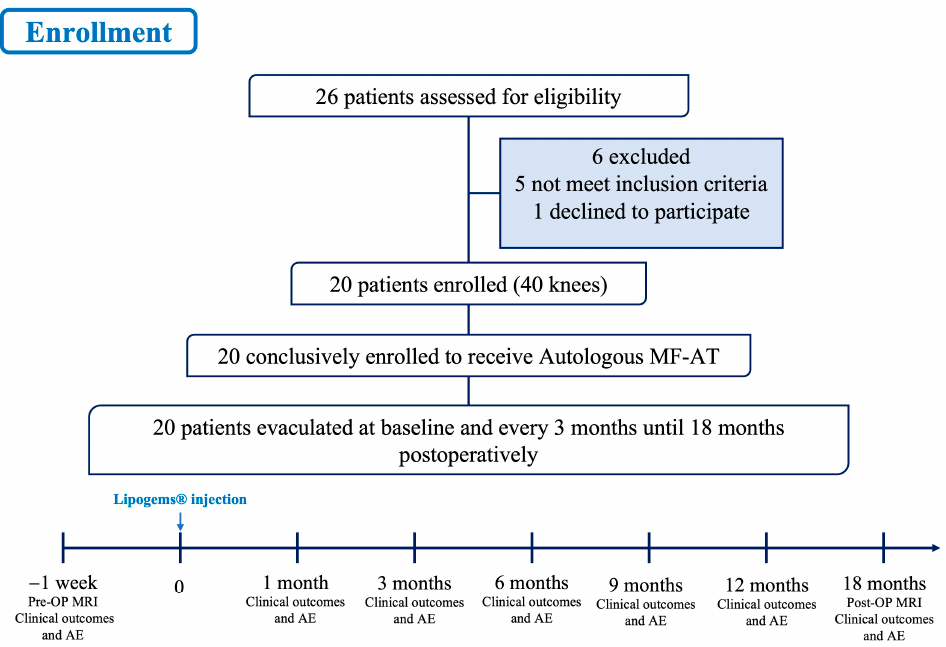
Figure 2. Flow chart of the clinical trial. MF-AT: micro-fragmented adipose tissue; AE: adverse events.